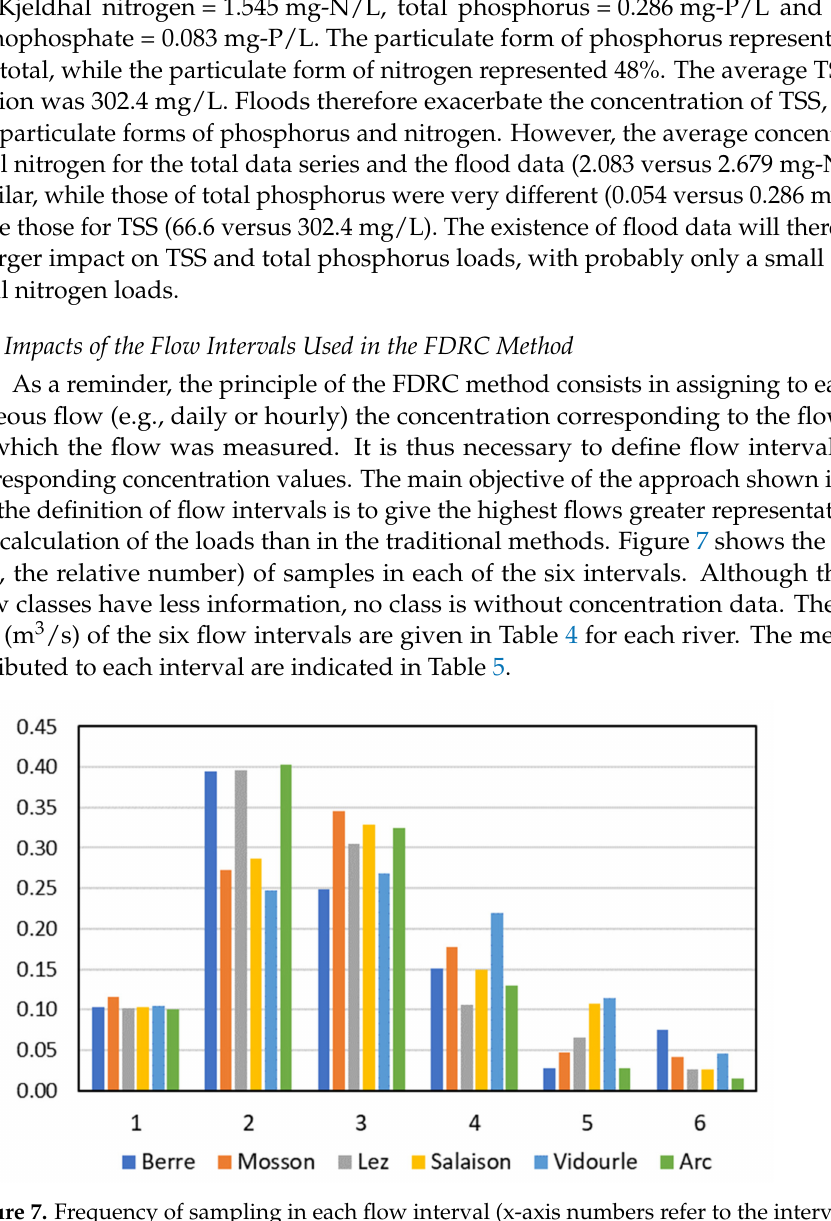
Figure 7. Frequency of sampling in each flow interval (x-axis numbers refer to the intervals defined in Tables 4 and 5). Table 4. Limit values (m 3 /s) of the six flow intervals for the six